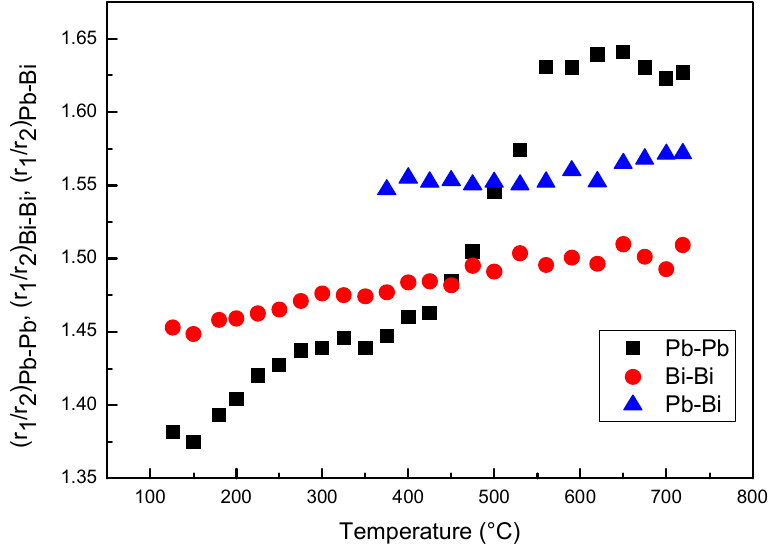
Figure 7. Ratios r 2 / r 1 of Bi–Bi, Pb–Pb and Pb–Bi pairs vs. temperature. The relative amounts of Bi–Bi, Pb–Pb and Pb–Bi pairs vs. temperature are plotted in Figure 8.